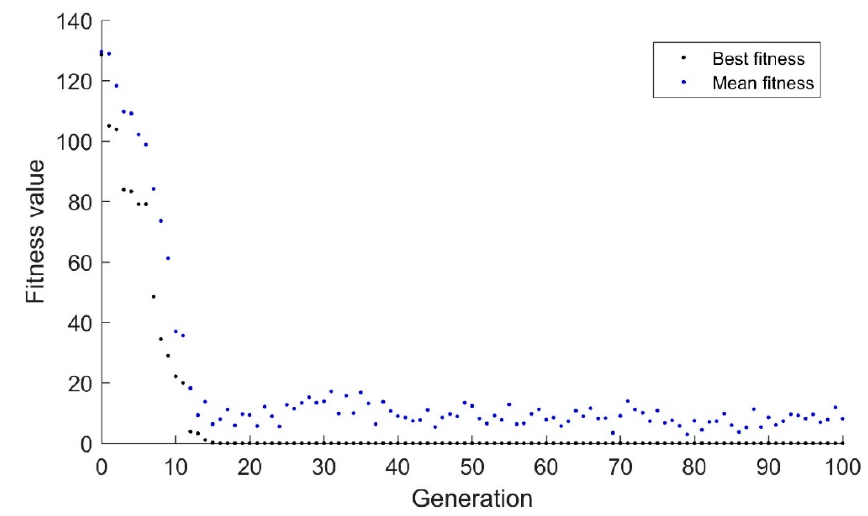
Figure 6. A real-valued genetic algorithm using a normally distributed mutation with standard deviation of 0.1 responding to a sudden jump in the target value after initial convergence.